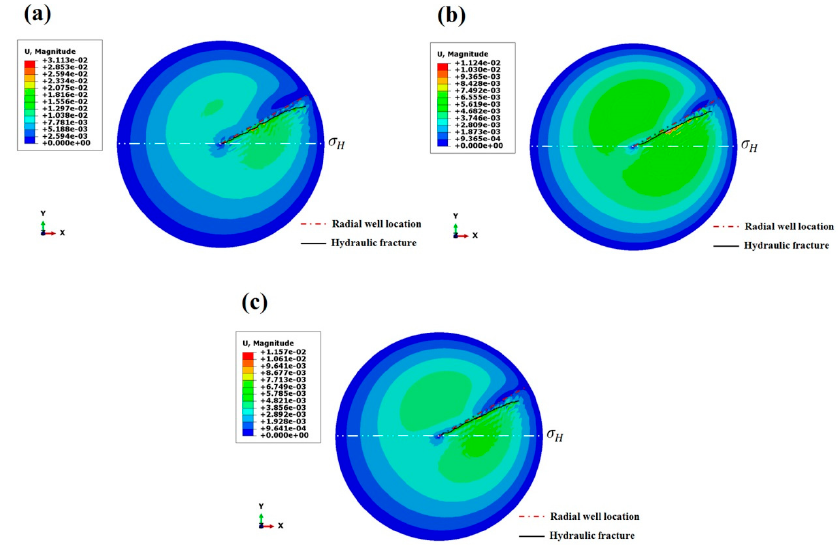
Figure 9. Simulation results of hydraulic fracture propagation guided by the single radial well under the different radial well lengths: ( a ) 10 m; ( b ) 15 m; and ( c ) 20 m. When the Young’s modulus is 23 Gpa, the hydraulic fracture deflects after extending for 16.94 m along the orientation of the radial borehole, and its guidance factor is 0.017. When the Young’s modulus is 33 Gpa, the hydraulic fracture diverts after extending for 16.81 m along the radial borehole orientation, and its guidance factor is 0.018, which is the weakest guidance strength. When the Young’s modulus of reservoir rock increases by 20 GPa, the guidance factor increases by 20%. Thus, an increased Young’s modulus of the reservoir weakens the guidance of a radial borehole, but this weakening degree is really small.